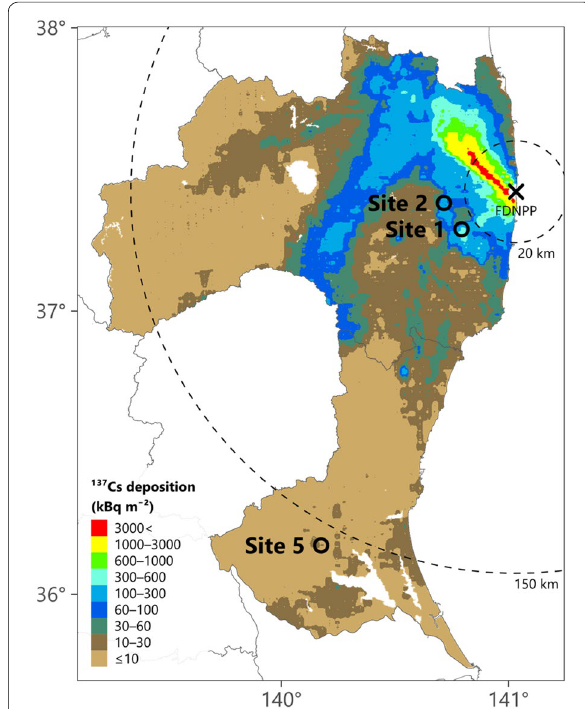
Fig. 1 Map of sampling sites and 137 Cs deposition density in Fukushima and Ibaraki Prefectures, Japan. Deposition densities are given as of December 28, 2012 [25]. FDNPP, Fukushima Dai-ichi Nuclear Power Plant